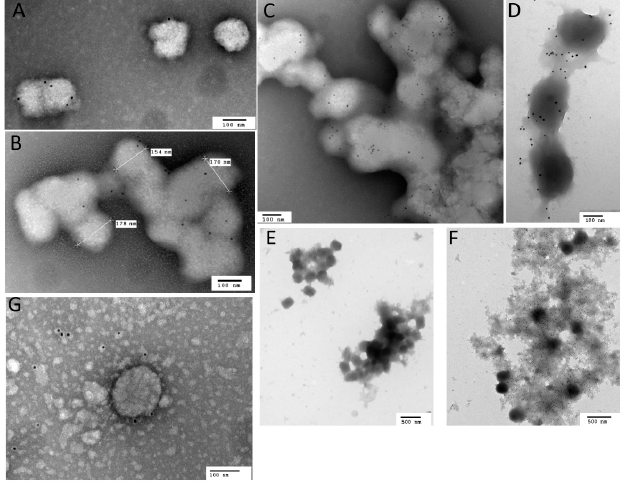
Figure 7. IEM of EV detected in oropharyngeal swabs of intravenously infected macaques. Oral swabs were collected three days post-exposure ( A – C , G ) or cell culture ( D – F ) with monkeypox virus prepared and stained with antibody against EV ( A – E , G ) or MV ( F ) for IEM. Cell cultures of mon- keypox virus were either prepared with ( D , E ) or without ( F ) purification. Measurements of individ- ual virions are given for ( B) . For ( A – D , G) , scale bars are 100 nM; 500 nM for ( E , F